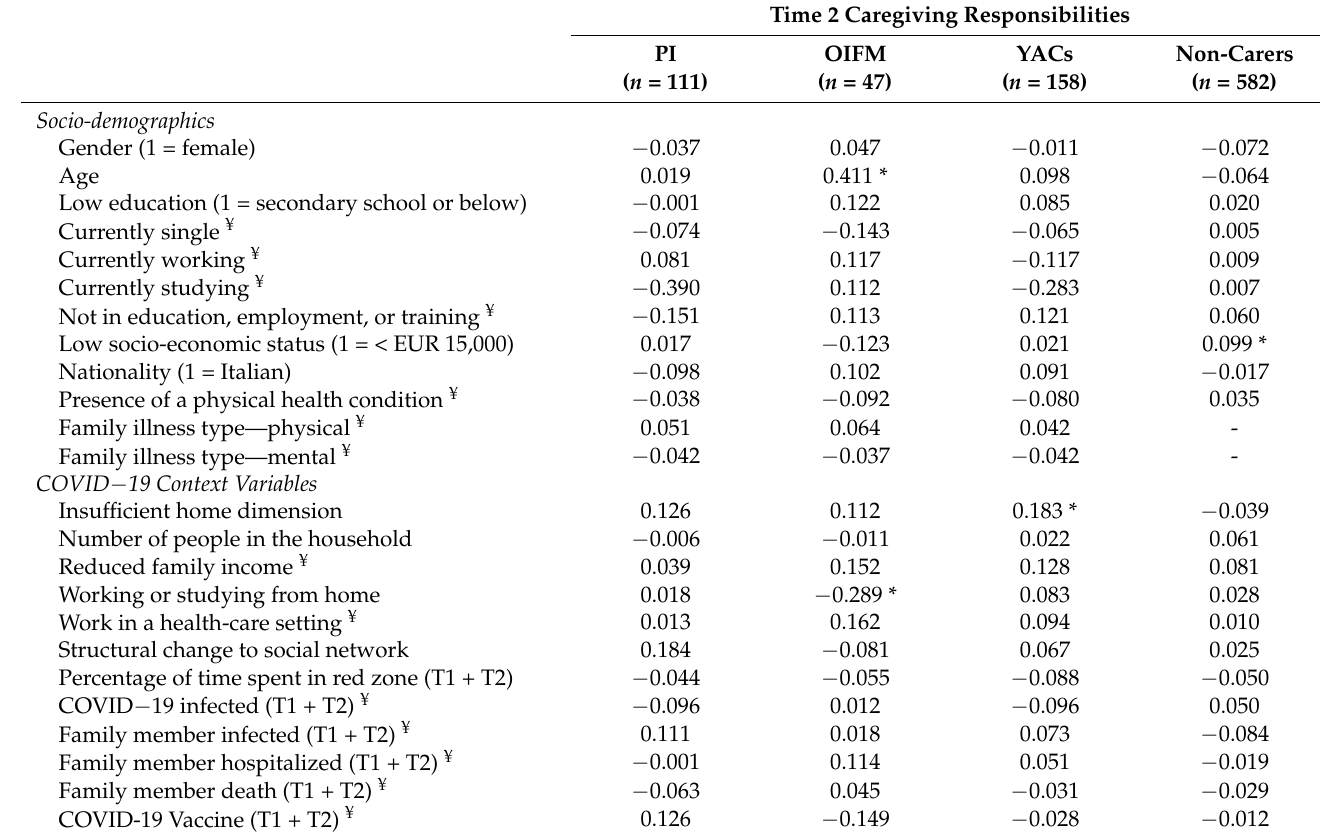
Table 2. Correlations between Time 1 Socio-demographics and Times 1 and 2 COVID-19 Context Variables and Time 2 Caregiving Responsibilities in the Parental Illness (PI), Other Ill Family Member (OIFM), Total Young Adult Carer (YAC), and Non-carer Groups. Time 2 Caregiving